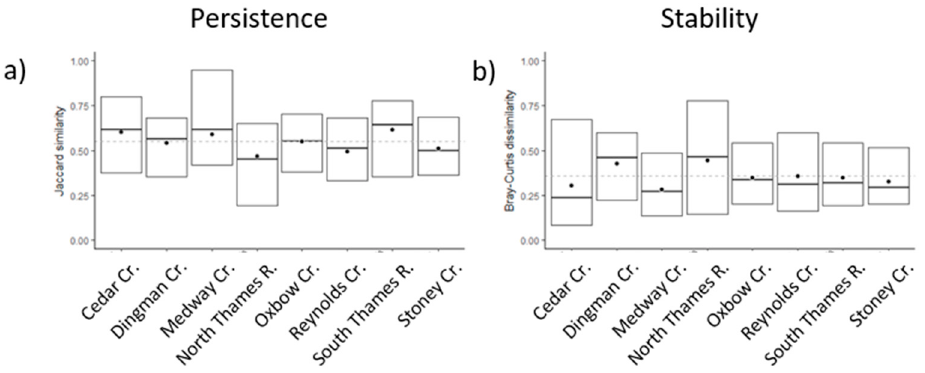
Figure 2. Boxplots of persistence ( a ) and stability ( b ) of benthic macroinvertebrate communities for eight rivers in the Upper Thames River Basin (southern Ontario, Canada) monitored for at least 14 years. Bars represent range of values, solid black lines represent median values, and black circles represent means. Gray dashed line indicates mean of all streams combined.